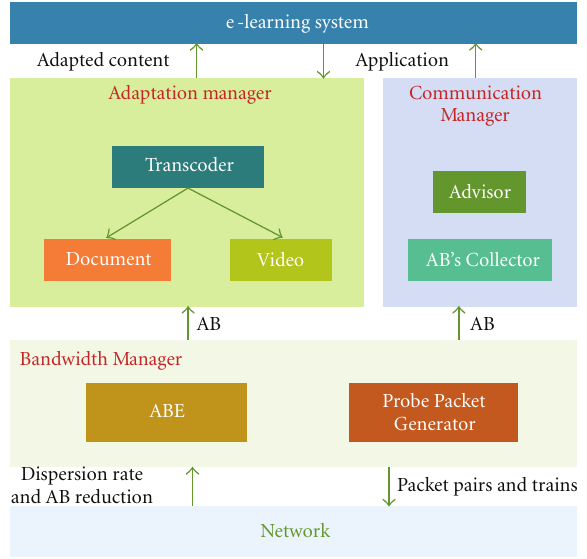
Figure 2: Architectural overview of Network-Aware Application for e-Learning System